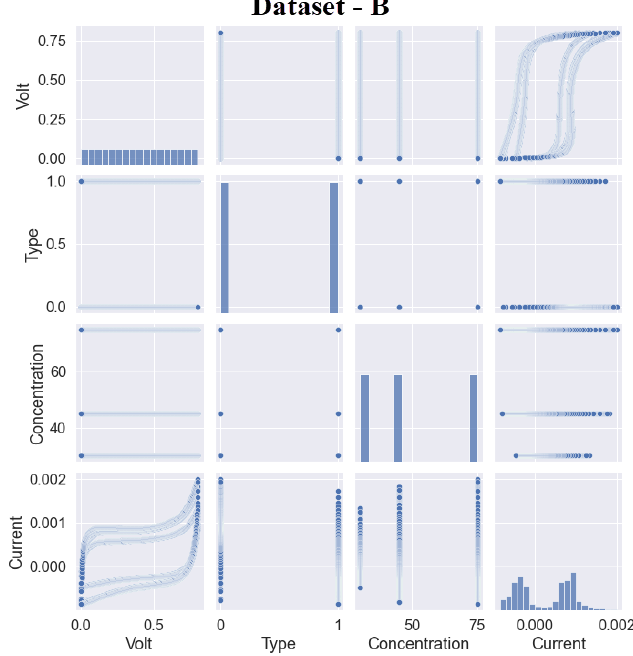
Figure 12. Pair distribution plots of Dataset